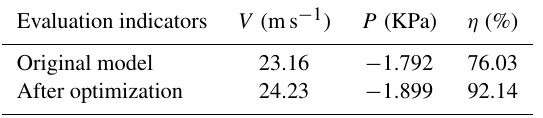
Table 7. Comparison of evaluation indicators before and after opti- mization.